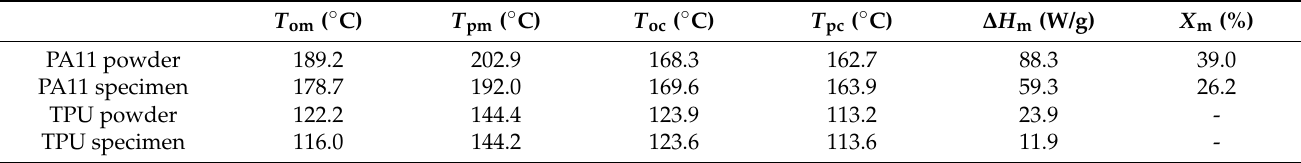
Table 1. Thermal properties of PA11 and TPU